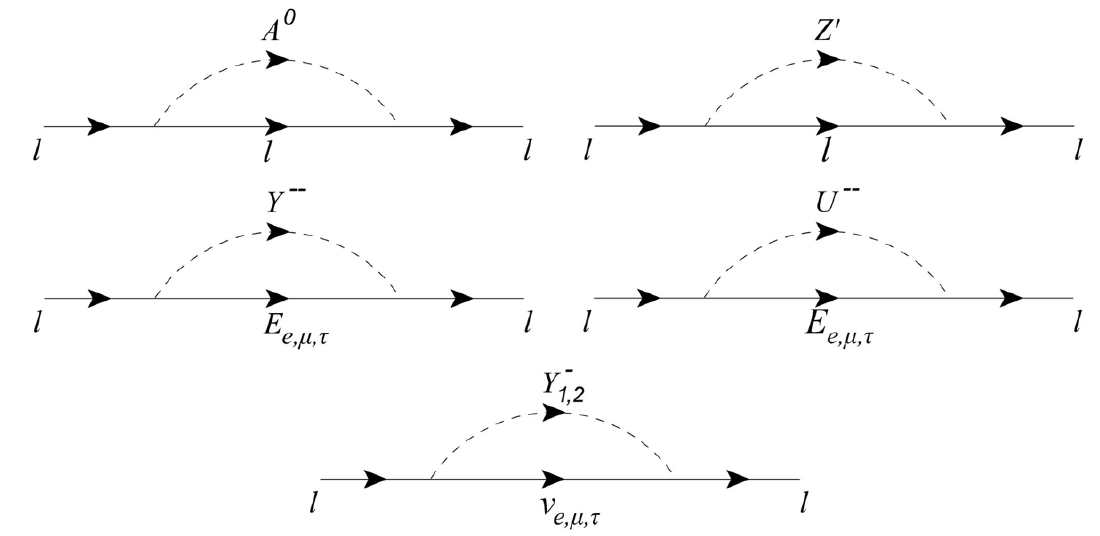
Figure 1 . 1 loop diagrams for the MDM. The fermion l indicates either an electron or a muon. The 3{3{1 model contribution to the MDM comes from all these diagrams, considering two cases, when the photon is connected to the fermion and when the photon is connected to the boson (when